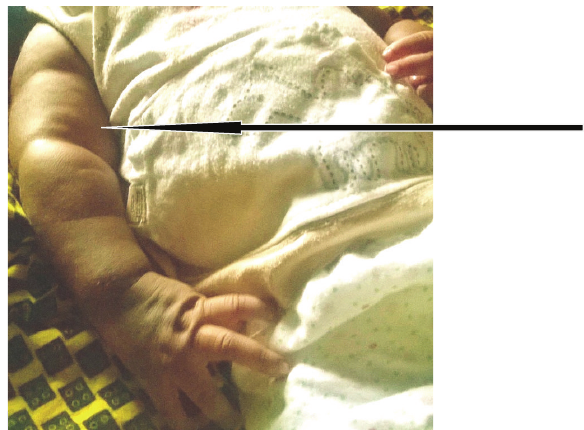
Figure 3: Slightly erythematous nodules noted subcutaneously within first week of life involving different parts of the body including the arms and forearms. Thus arms appear larger than they should be due to edema.